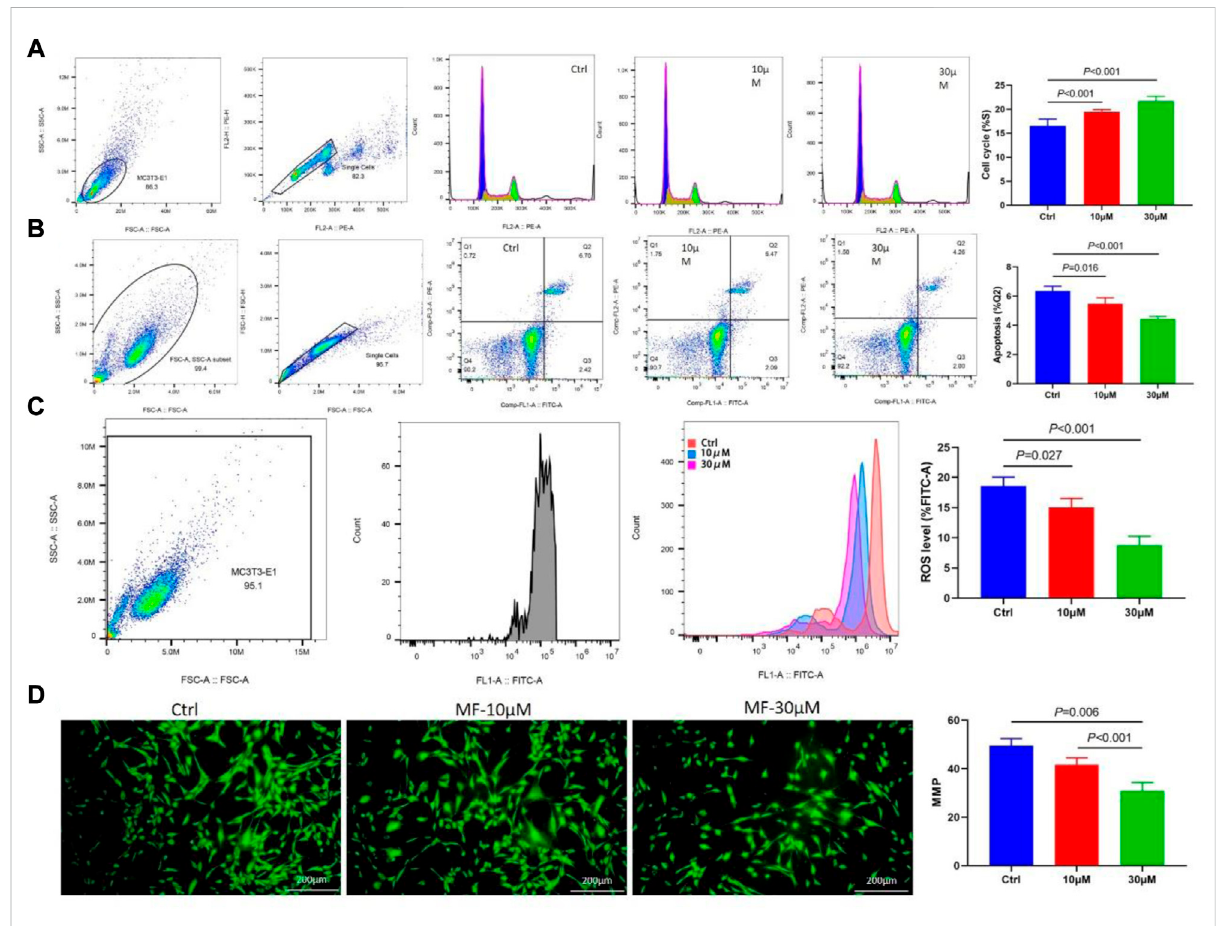
FIGURE 3 (A) Flow Cytometry of the cell cycle, when the concentrations were 10 μ M and 30 μ M, the percent of the S phase signi fi cantly increased when compared with the control group ( p < 0.001, respectively). (B) Flow Cytometry of cell apoptosis in the Q2 phase signi fi cantly decreased when